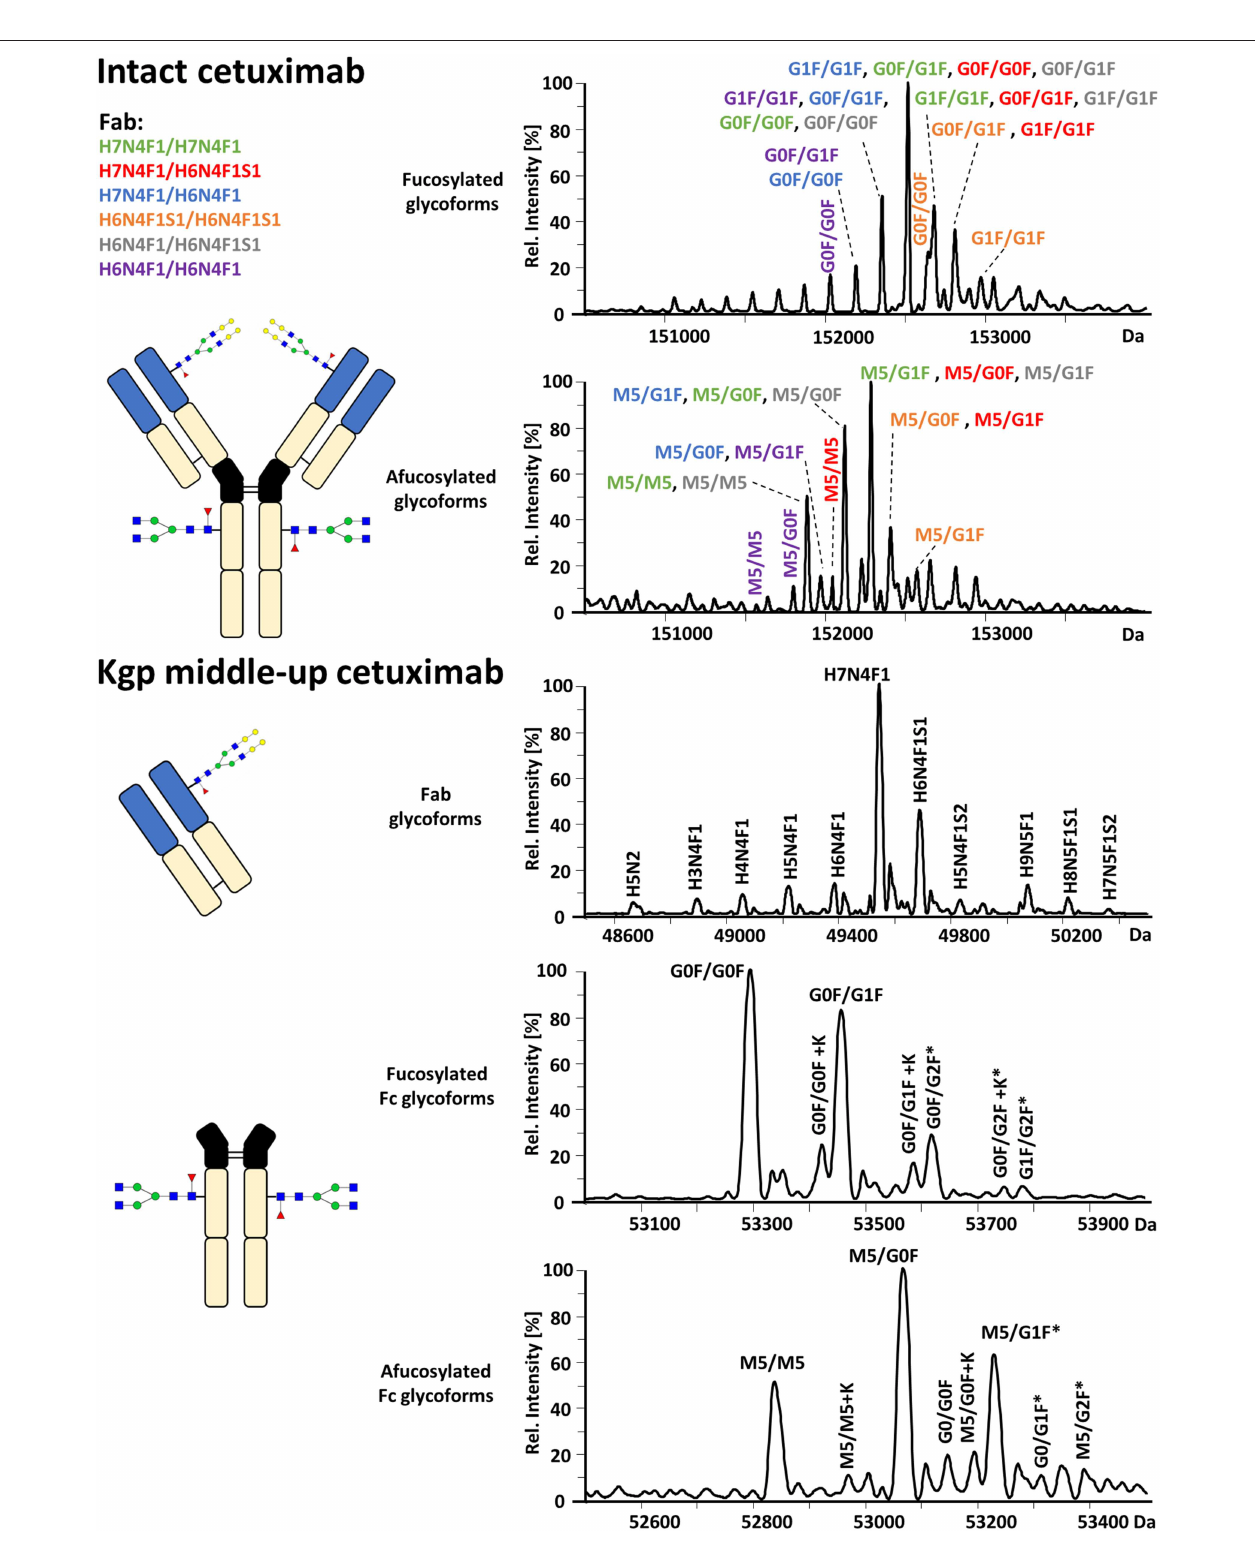
FIGURE 5 | Assignment of cetuximab glycoforms on intact and Kgp middle-up level by Fc È RIIIa AC-MS. Fc glycoform assignment of intact cetuximab was restricted to 6 different Fab glycoform pairings indicated by a color code. The broad peaks often contain multiple isomeric and non-resolved glycoforms ( Supplementary Table 3 ). Thirty four out of thirty six possibilities are assigned to peaks. For Kgp middle-up Fc È RIIIa AC-MS, the composition of Fab glycoforms were assigned as well as the Fc fragments (*indicates additional isomers). All observed deconvoluted masses for intact and middle-up analysis are listed in Supplementary Tables 3–5